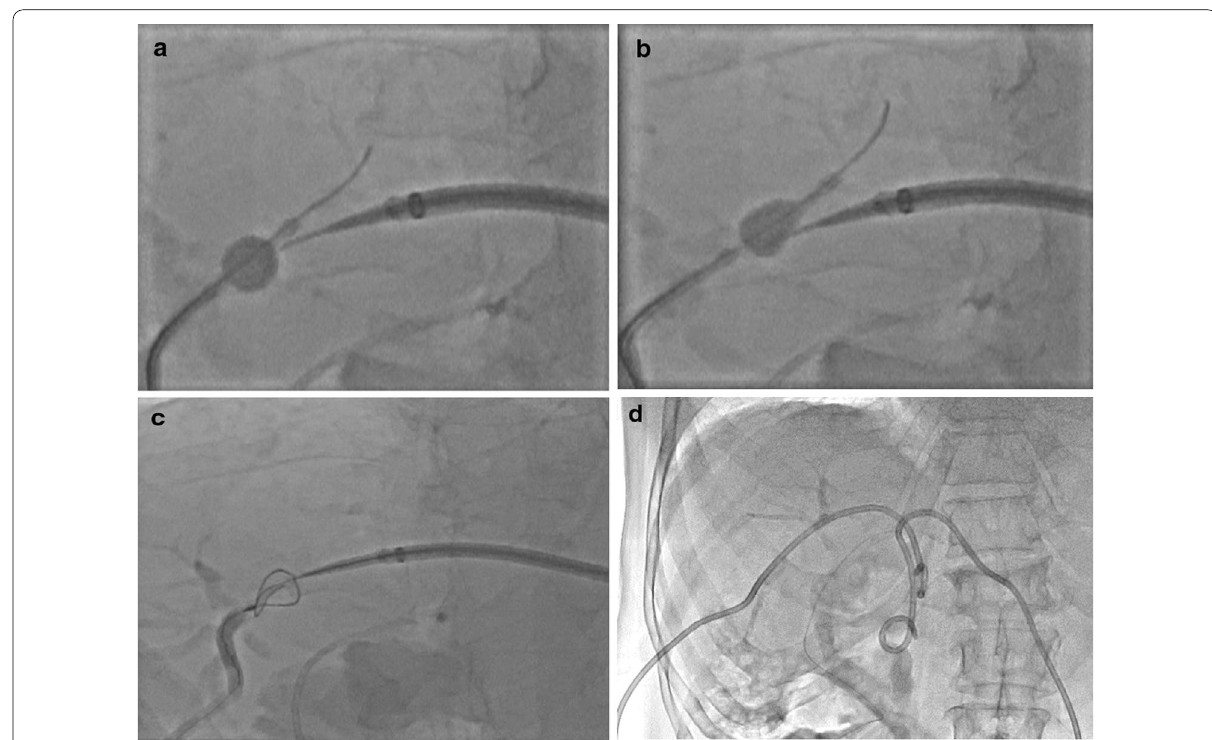
Fig. 3 a A 6-F balloon catheter was placed at the distal end of right biliary obstruction, and a transseptal needle was inserted into the ostium of right hepatic duct through the left biliary access route. b The right hepatic duct was punctured by targeting the inflated balloon with the transseptal needle. c Following the successful puncture, a 0.014-in. guidewire was advanced through the transseptal needle lumen and pulled out by a loop snare catheter from the right biliary access route. d An internal–external PTBD catheter was placed into the common bile duct